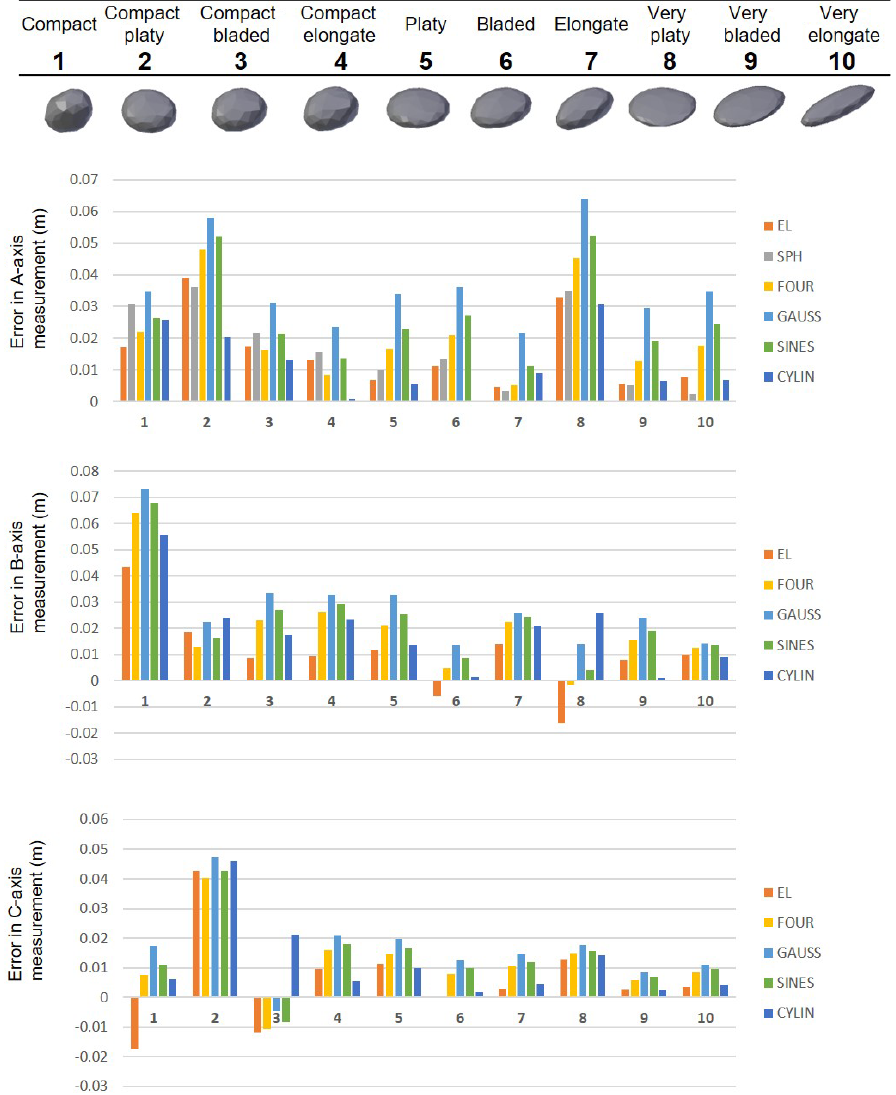
Figure 10. Error in dimension measurement for each fit compared to a set of manual measurements for the rounded synthetic blocks. EL: least-squares ellipsoidal fit; FOUR: RFSHAPZ Fourier fit; GAUSS: RFSHPZ Gaussian fit; SINES: RFSHAPZ sum of sines fit; CYLIN: RFCYLIN